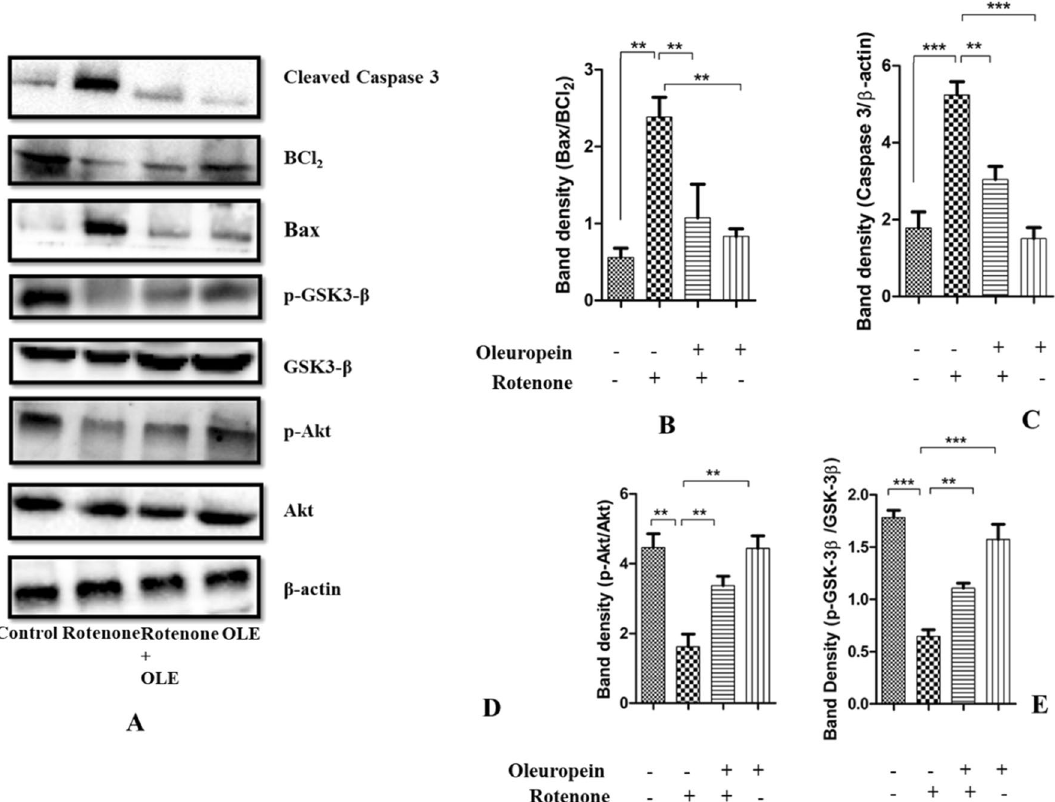
Figure 9. ( A – E ) Using the Western blotting method and protein densitometry analysis, the relative expression of Bax, Caspase-3, Bcl-2, p-Akt and p-GSK-3β was examined in the SN of mice ( A ). OLE inhibited the increase in ratio of Bax/BCl 2 ( B ) and decrease in the expression of cleaved caspase 3 ( C ). Additionally, phosphorylation of Akt ( D ) and GSK3β ( E ) was increased by OLE. The one-way ANOVA was used to analyse the data, followed by the Newman–Keuls test. The mean ± SEM (n = 6) is used to depict the values (***p < 0.001 and **p < 0.01).